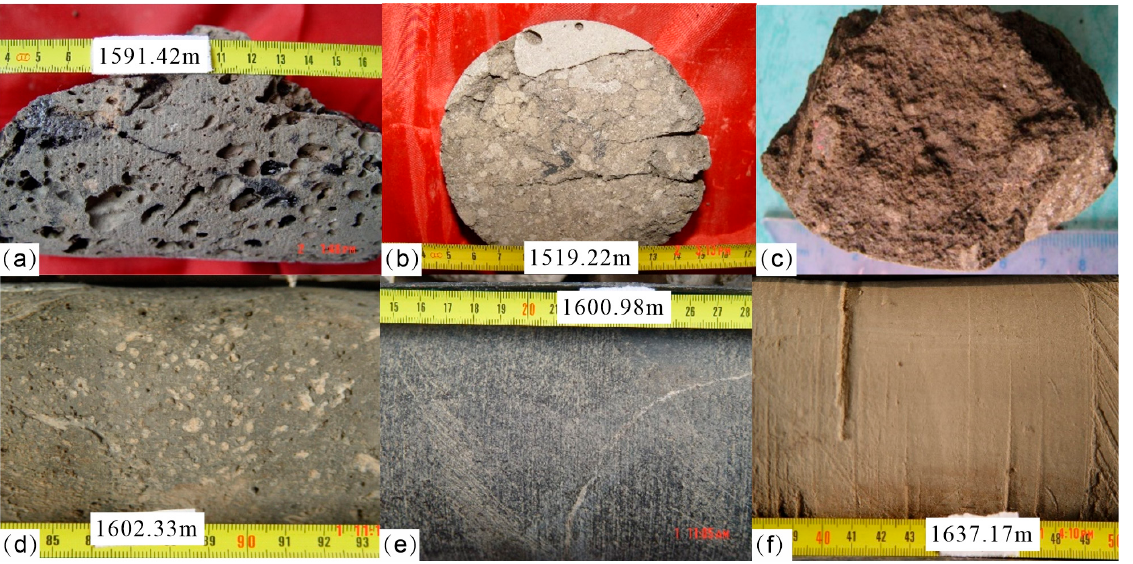
Figure 2. Typical core photos of main rock types in the Zao35 fault block volcanic reservoir. ( a ) stomatal basalt, Jun 21–23, 1591 m; ( b ) volcanic breccia, zao78, 1519 m; ( c ) tuff, zao78, 1506.67